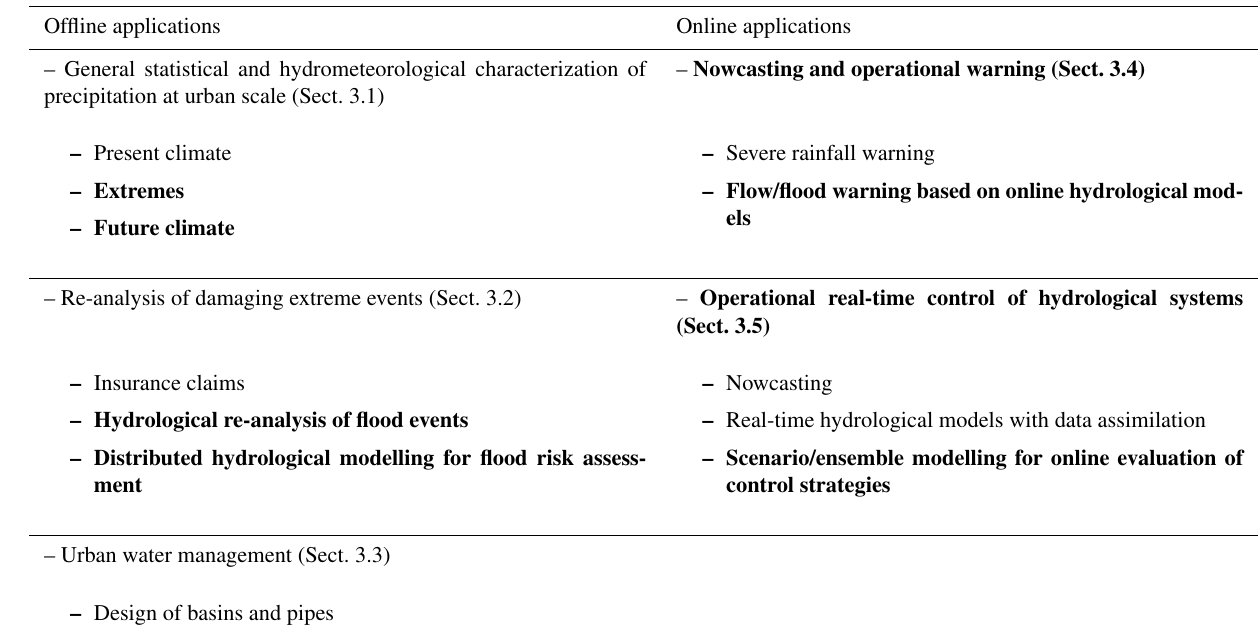
Table 3. Application fields for radar rainfall in urban hydrology. Applications that have emerged significantly since Einfalt et al. (2004) are marked with bold. Numbers in parentheses indicate which sub-section discusses the particular